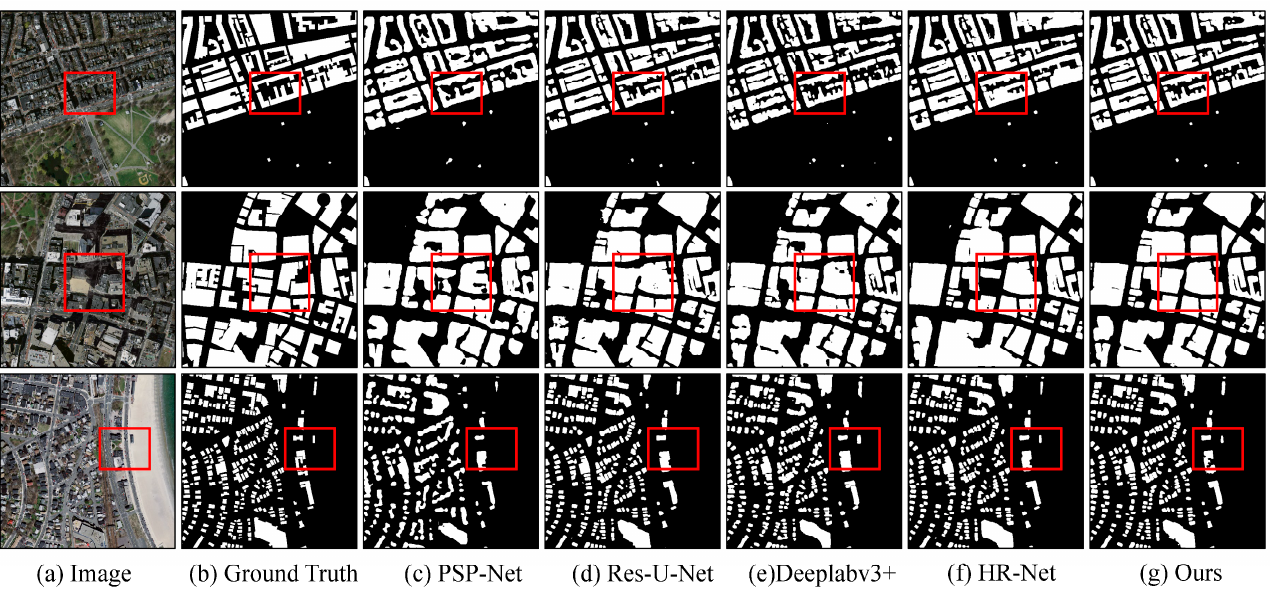
Figure 8. Examples of MEC-Net using the Massachusetts dataset.